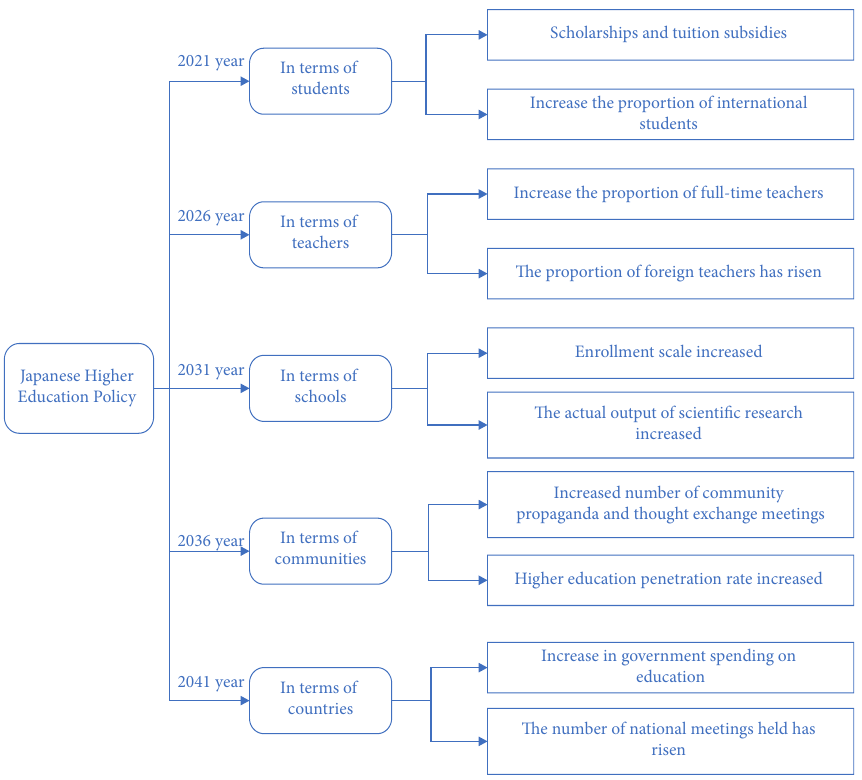
Figure 7: Schedule of Japanese higher education in the next 20